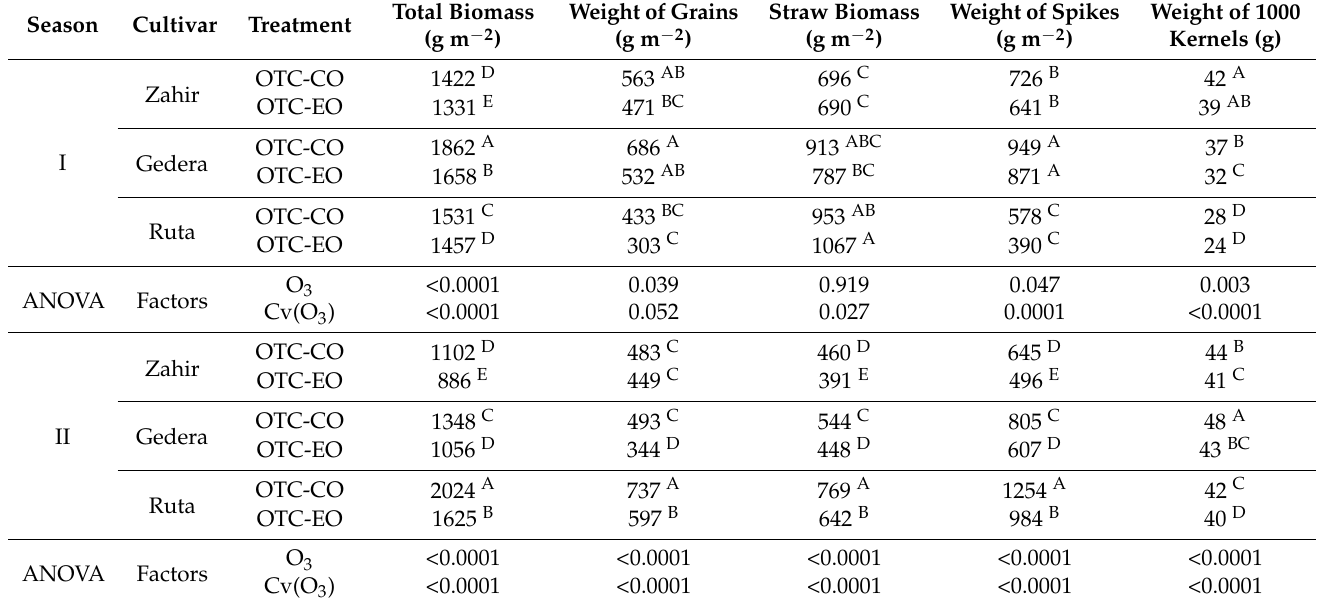
Table 4. Yield parameters of all cultivars in the OTC enriched with O 3 (OTC-EO) and corresponding controls (OTC-CO) during season I and season II. Values are presented as means of plants sampled at maturity from each replicate row (n = 5) of each cultivar—(see Section 2.8). p -Values of factors O 3 exposure (O 3 ) and cultivar within O 3 effect Cv(O 3 ) for yield parameters by ANOVA are also shown. Different superscript letters indicate significant differences ( p < 0.05) according to Student’s t